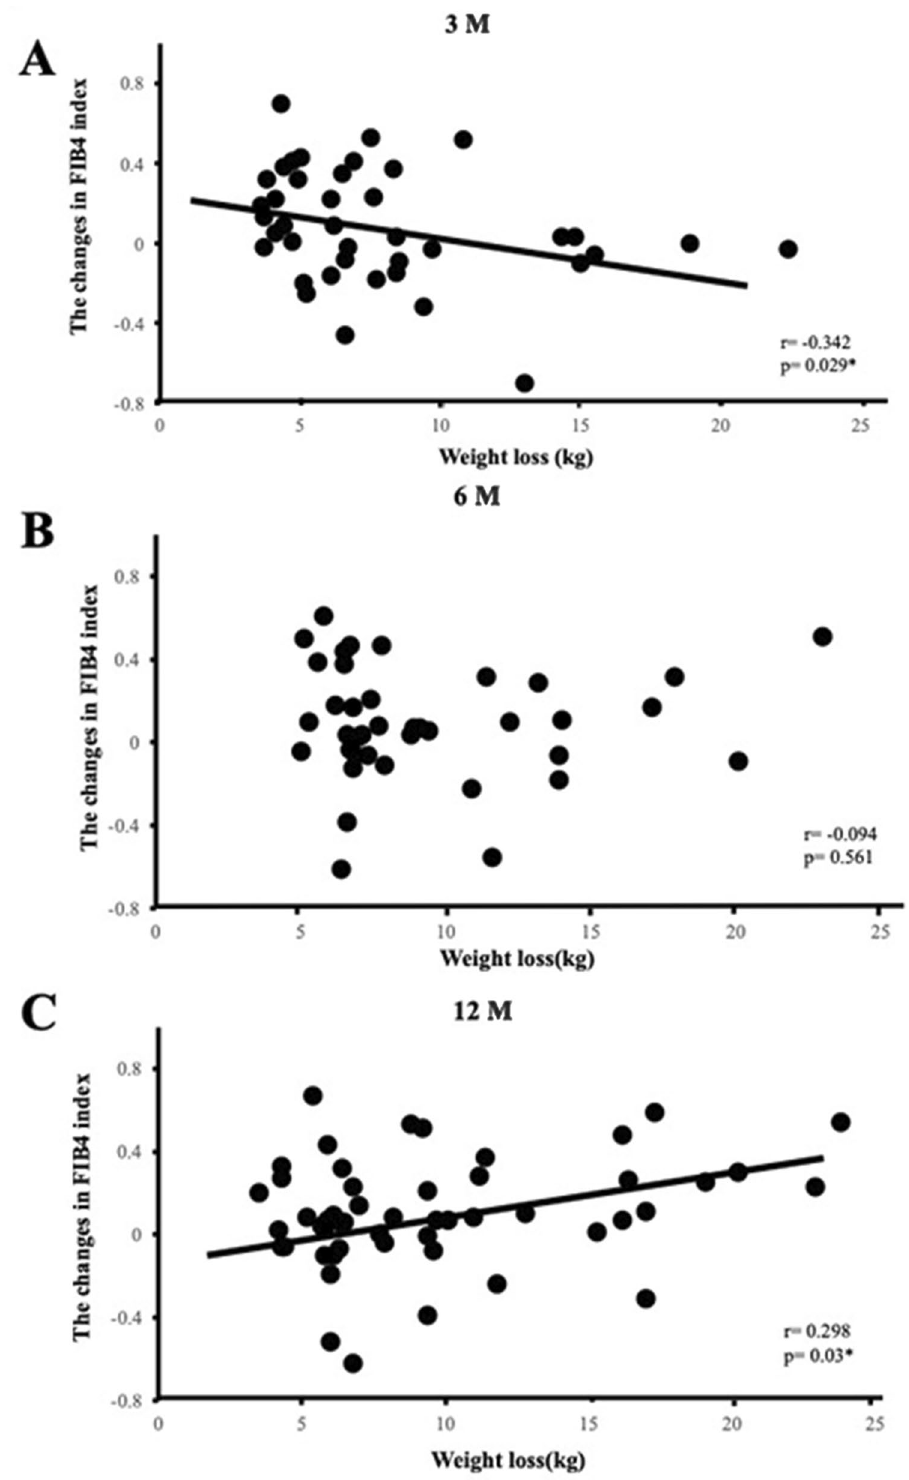
Figure 1. Correlation between the amount of weight lost and changes in the FIB4 index after 3 ( A ), 6 ( B ), and 12 ( C ) months (M) of weight reduction therapy. Patients reduced their body weight by more than 5% from the baseline at each time point. *p <